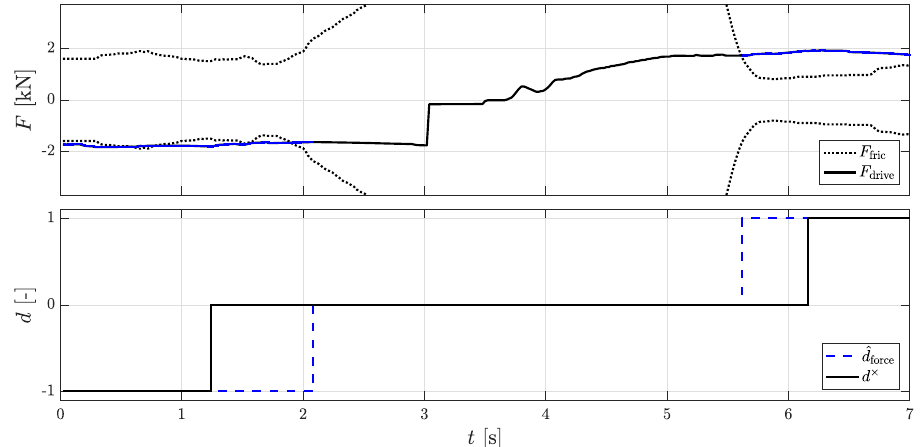
Figure 4. ( Top ): Calculated forces for the force equilibrium method for detection of rolling directions; ( bottom ): the rolling directions of the DWPC signal d × and the force equilibrium method ˆ d force